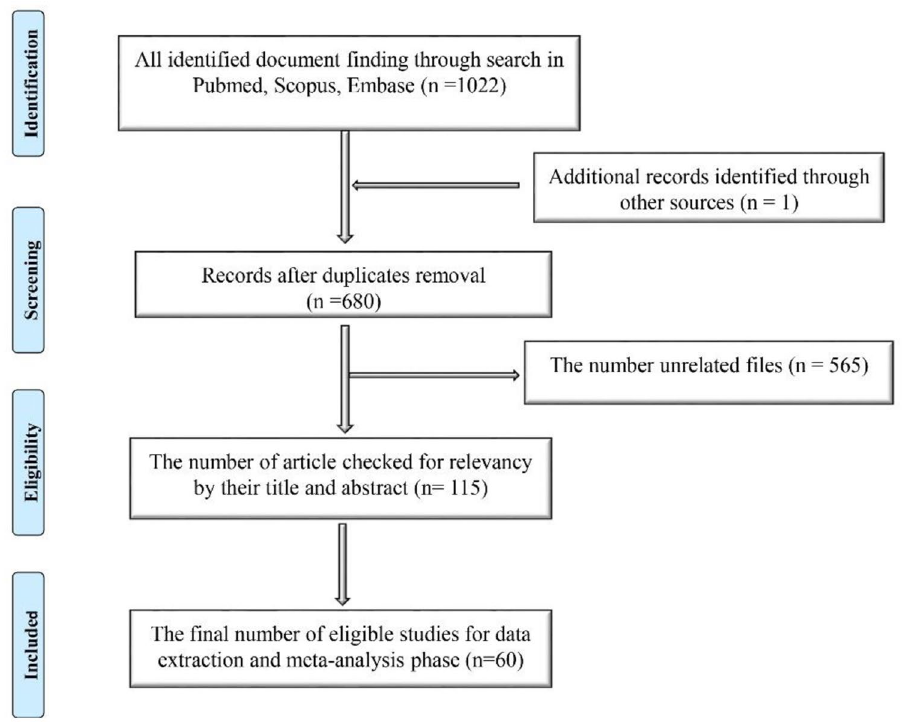
Figure 1. The number of articles during several steps based on the PRISMA flow diagram (2009). (http://www. prism a-state ment.org/PRISM AStat ement /Citin gAndU singP RISMA